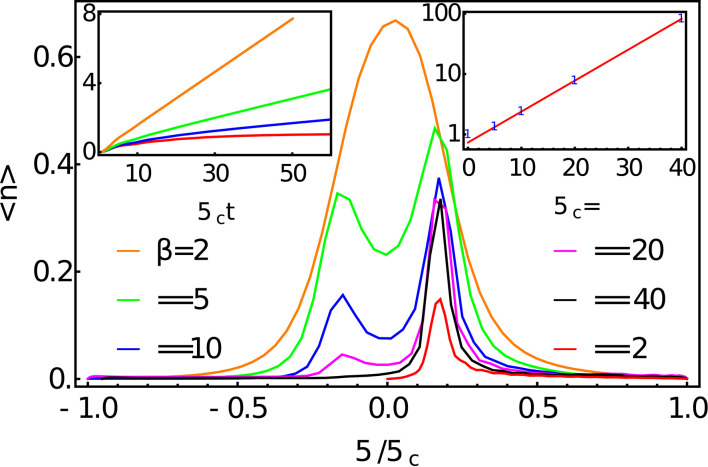
Bath mode occupations 〈nω〉=〈aω†aω〉 for the extended environment after the TLS has decayed. The TLS is governed by a Hamiltonian HS=ω02σz where ω0 = 0.2ωc and is coupled to an Ohmic bath with a hard cut-off via AS = σx. The coupling strength is α = 0.1. Left inset: total mode occupation as a function of time 〈n〉tot=∫-∞∞dω〈nω〉. Right inset shows 〈nωp〉+1〈nωn〉 plotted on a log scale against the inverse temperature, demonstrating the detailed balance of the absorption and emission rates.